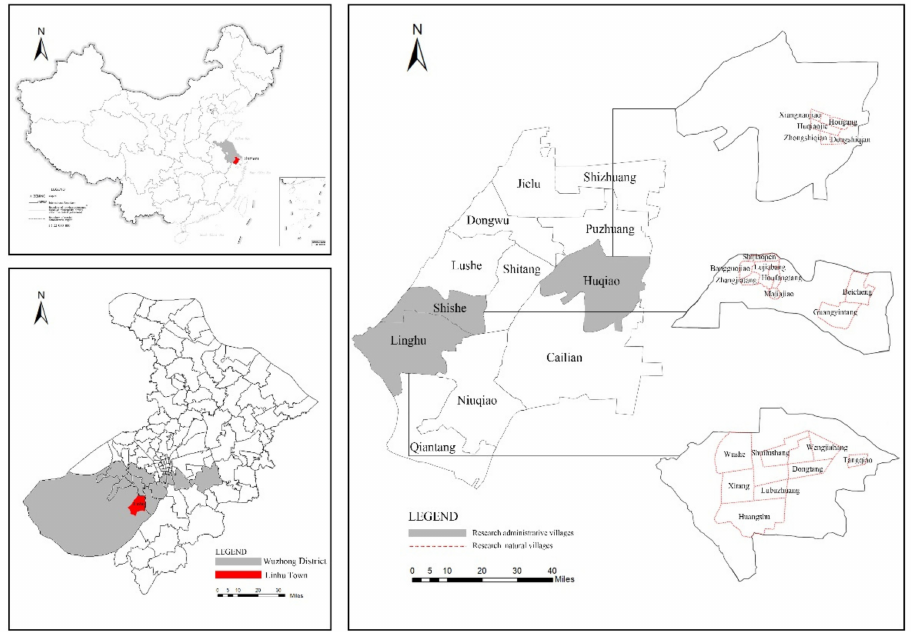
Figure 1. Location of Linhu Town in